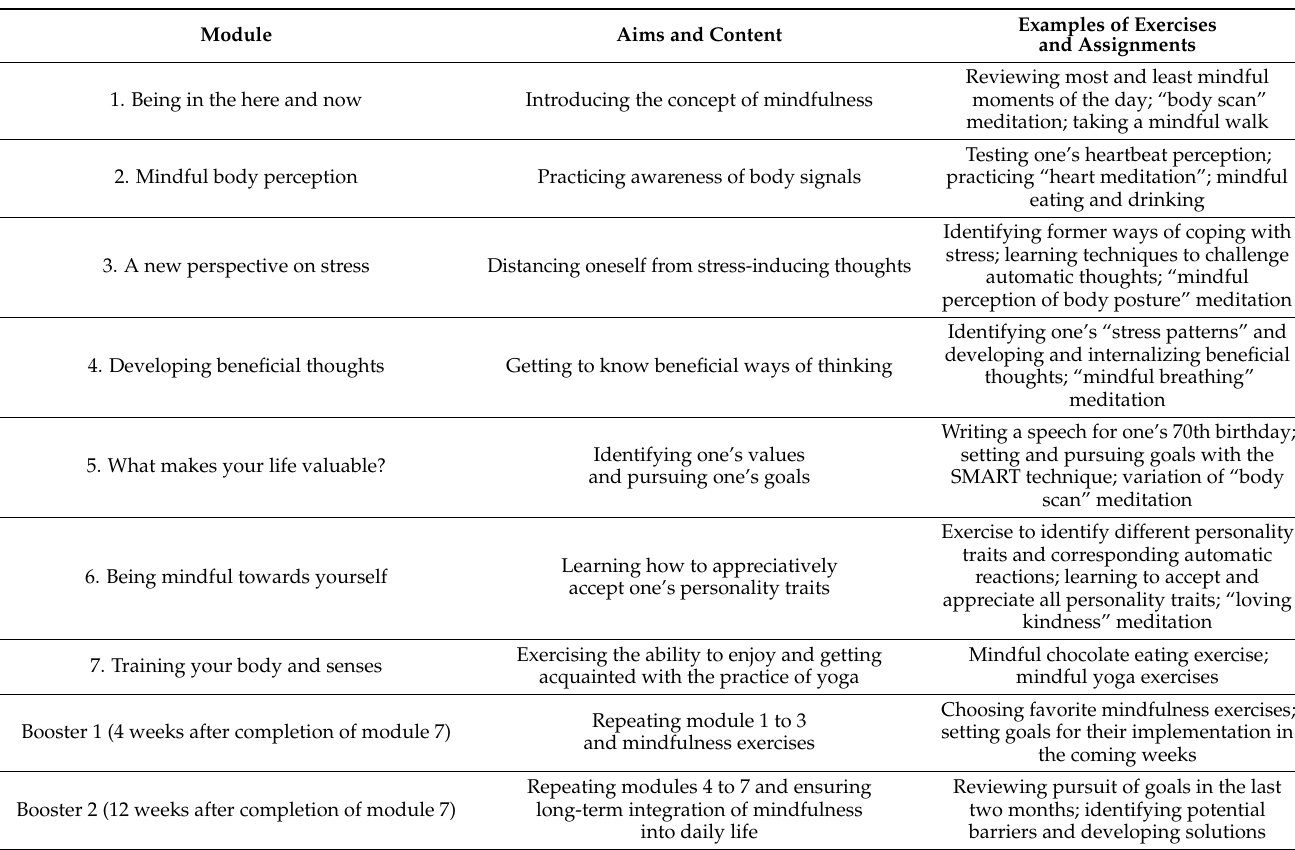
Table 1. Intervention content (see [34], slightly